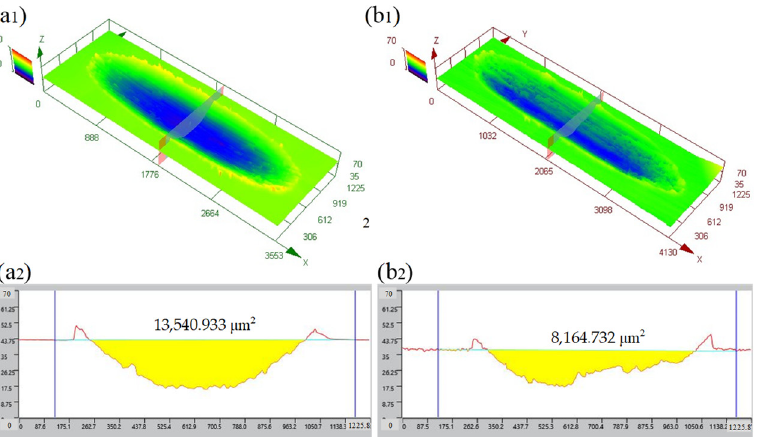
Figure 7. Three-dimensional wear morphology and sectional wear area: ( a1 , a2 ) 316L coating and ( b1 , b2 ) composite coating.